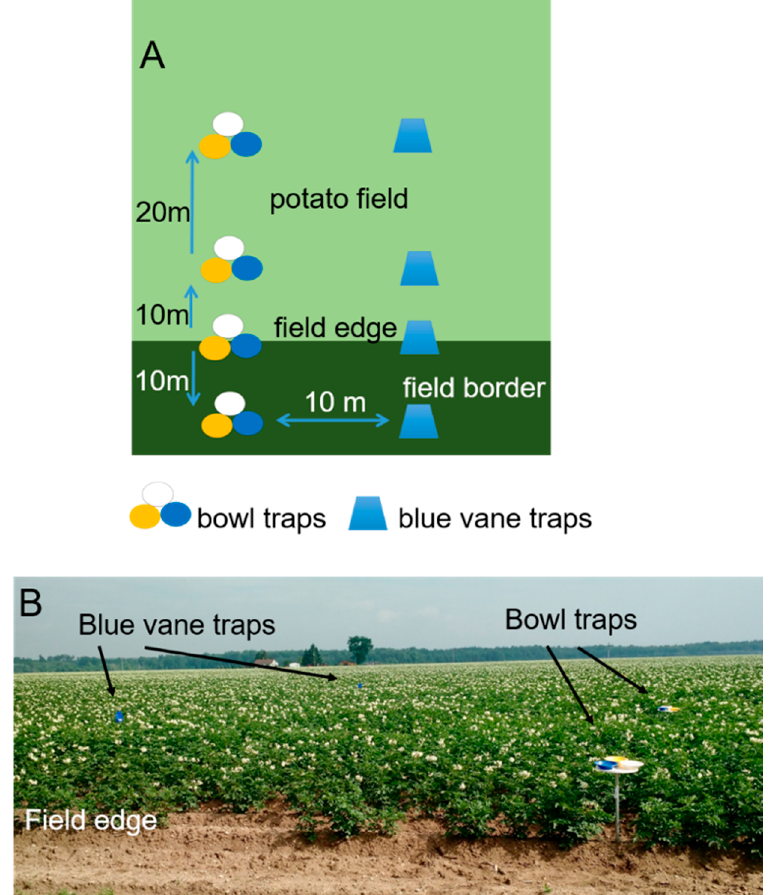
Figure 2. Transects of bowl traps and blue vane traps were placed in each potato field to survey the bee community. Bowl and vane transects were 10 m apart and extended from the field border to 30 m into the field; figure not to scale ( A ); Bowl trap platforms were elevated to canopy height on metal poles; blue vane traps were suspended at canopy height from a metal pole ( B ). Traps were emptied after 48 h.